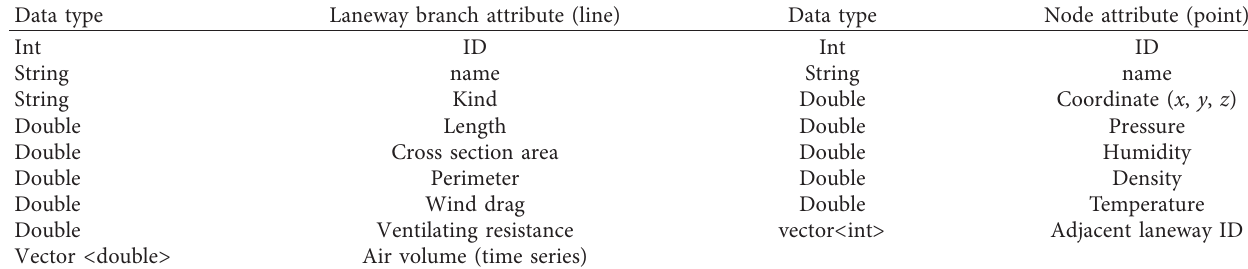
Table 2: Data structure for laneway branch and node.